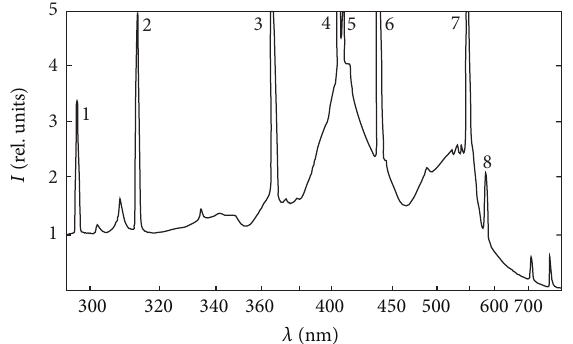
Figure 3: Emission spectrum of Kr (850Torr) + Hg (1.5 mTorr) mixture: wavelengths (nm): 297 ( 1 ); 312.5 ( 2 ); 365 ( 3 ); 404.7 ( 4